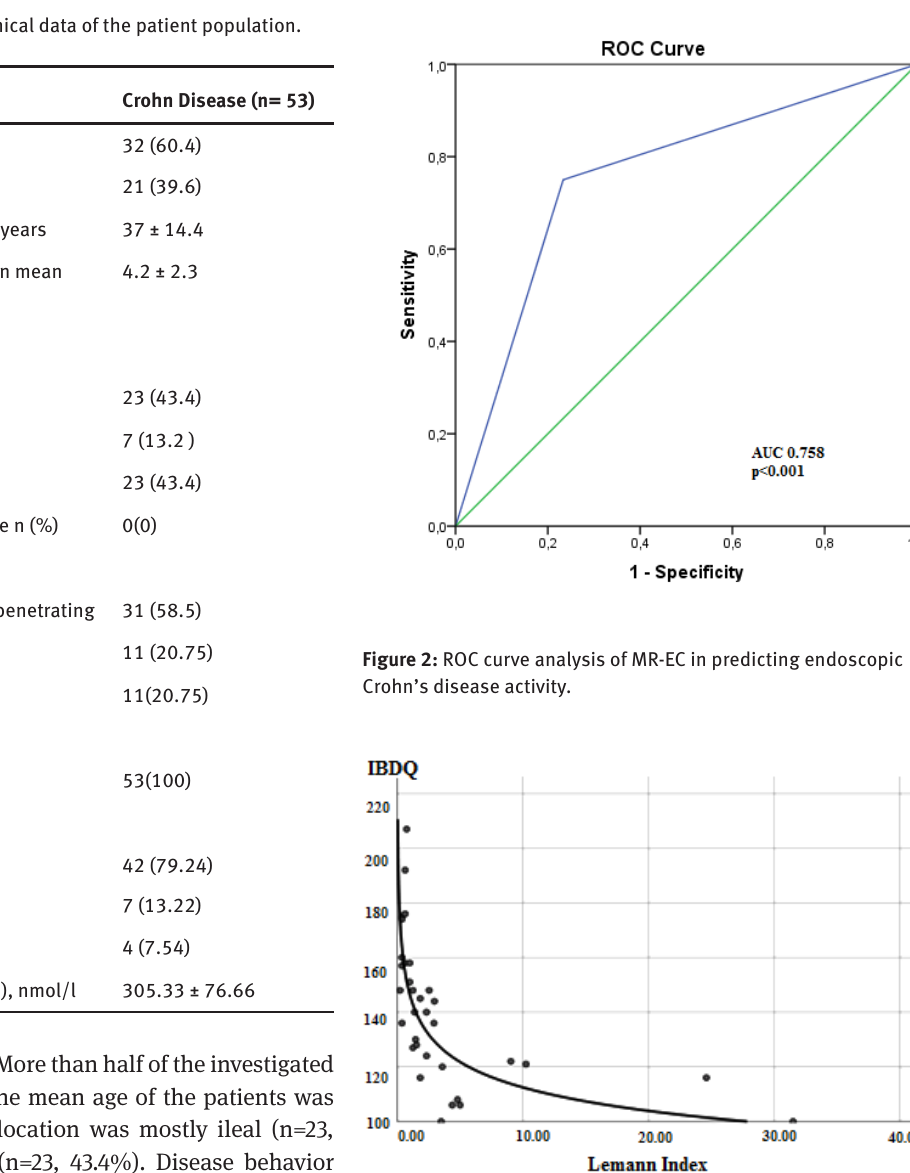
Figure 3: Correlation of Lemann Index and the Inflammatory Bowel Disease